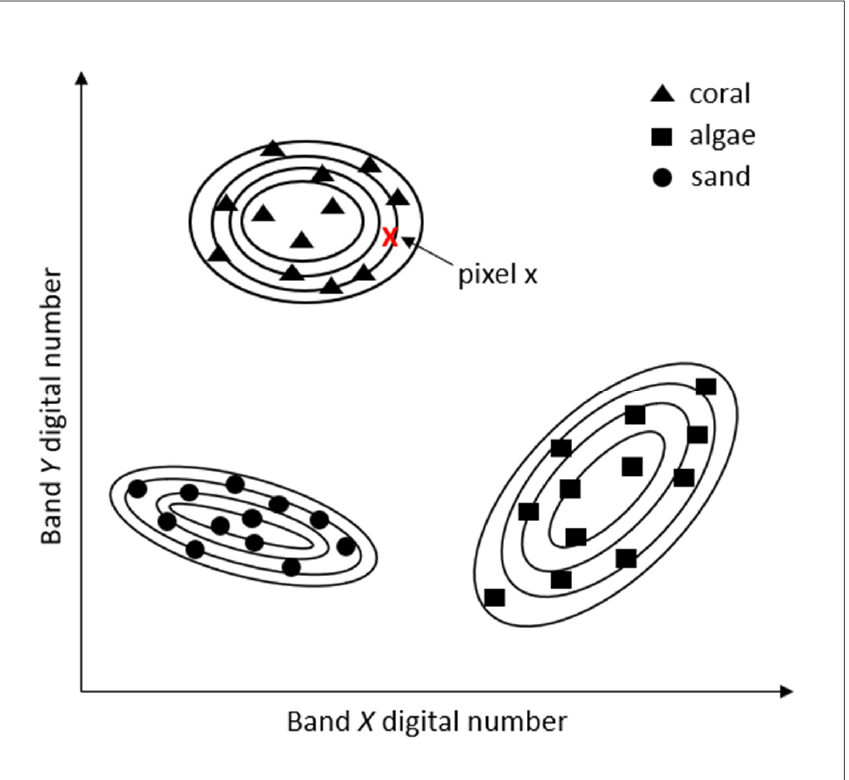
Figure 1. Basic conceptualisation of maximum likelihood classification illustrating 3 different classes with equiprobability contours.